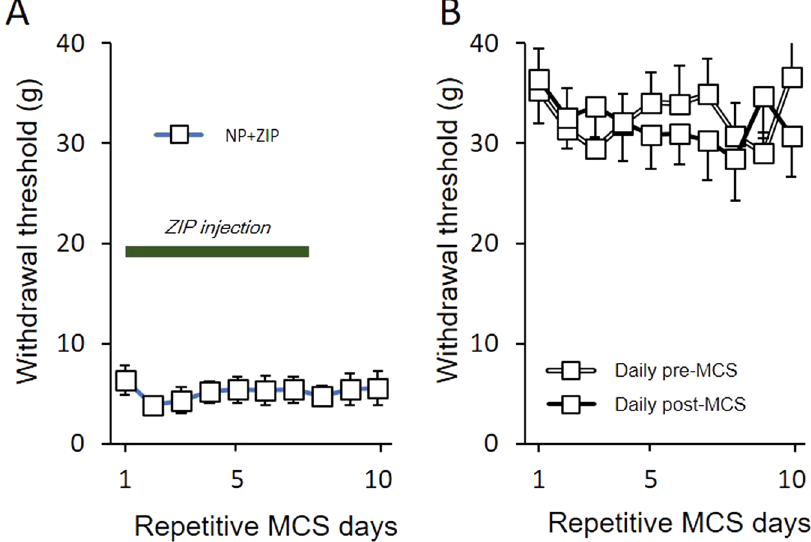
Figure 3. The effects of ZIP injection on neuropathic rats and MCS on naïve rats. ( A ) The effects of ZIP injection on neuropathic rats. In the behavioral test after 14 days in the NP rats, the withdrawal thresholds did not significantly change between the duration of ZIP injection and the end of ZIP injection days. ( B ) For evaluation of the effects of MCS on the control (non-injured) rats, the mechanical thresholds were measured daily pre- and post-MCS. In the comparison of pre- and post-MCS, the withdrawal thresholds did not change over the duration of MCS.